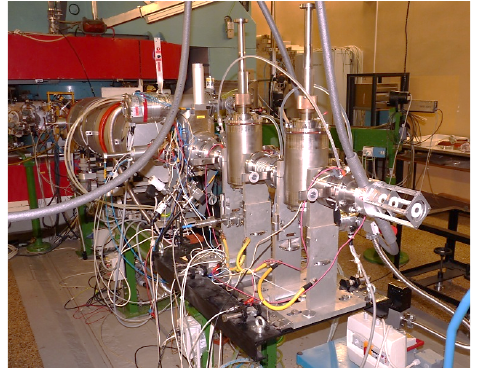
Figure 2. Beryllium target station driven by isochronous cy- clotron U-120M at NPI Rez.